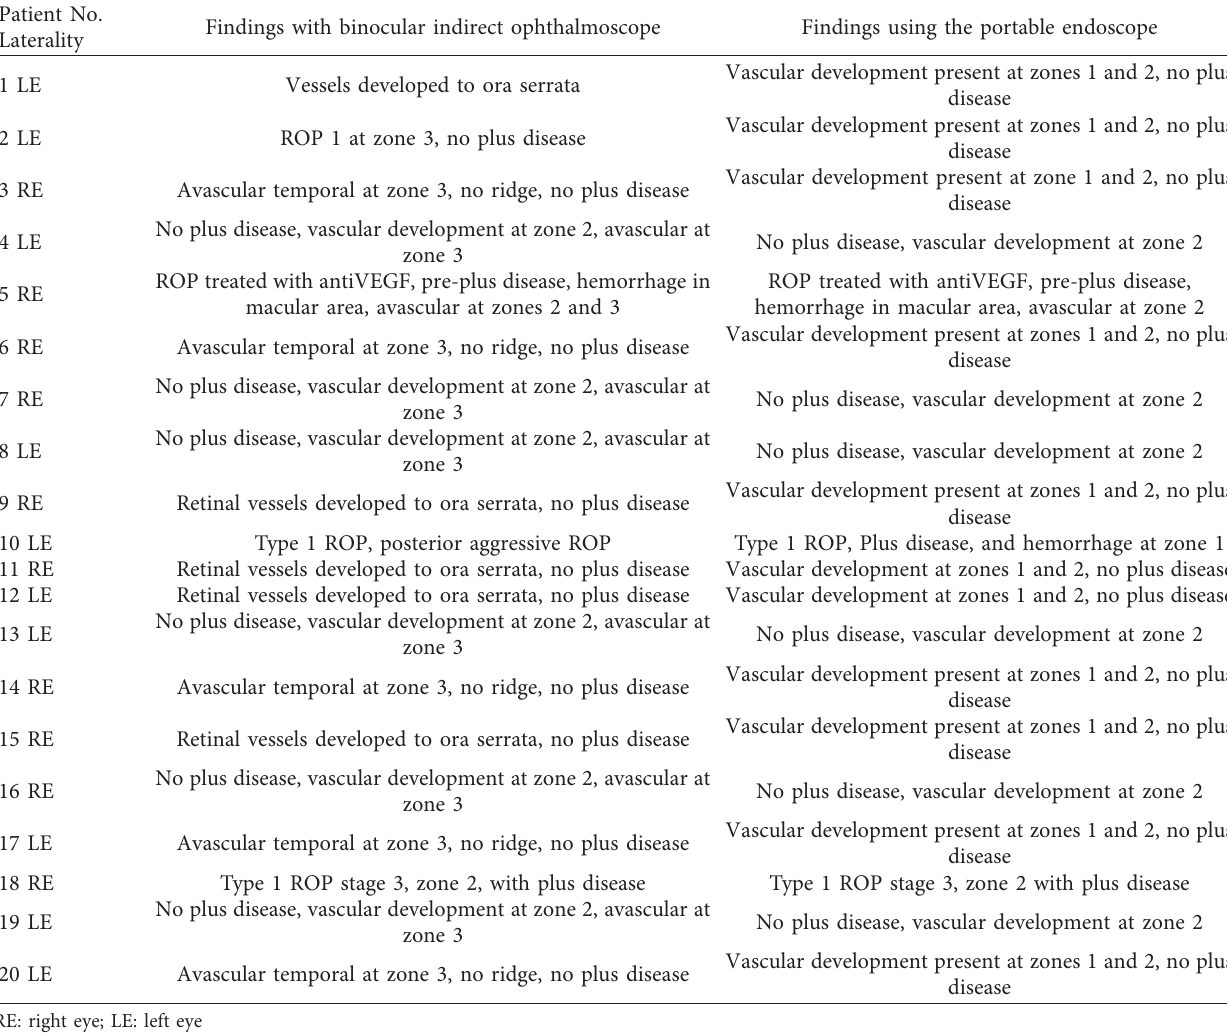
Table 1: Comparison of clinical fundus findings identified with BIO binocular indirect ophthalmoscope and portable endoscope. Patient No.